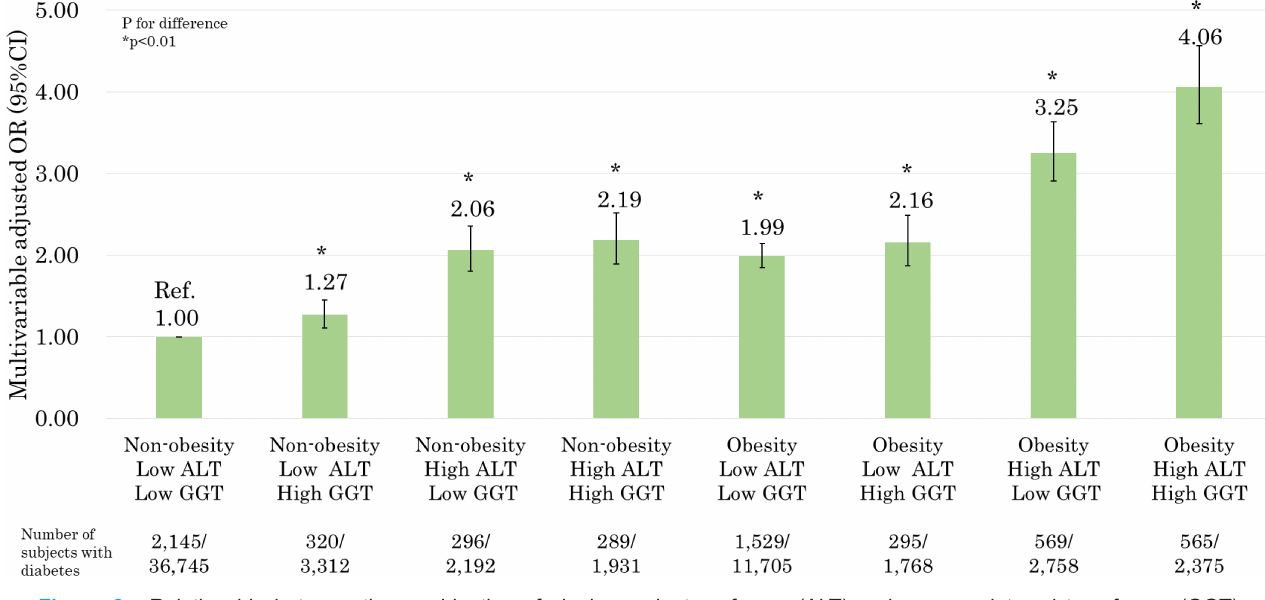
Figure 2. Relationship between the combination of alanine aminotransferase (ALT) and gamma-glutamyl transferase (GGT) levels with the prevalence of diabetes mellitus (DM) in obese and non-obese individuals (adjusted for age, sex, smoking status, alcohol drinking status, family history of diabetes, hypertriglyceridemia, high low-density lipoprotein [LDL], low high-density lipoprotein [HDL], hypertension, physical activity, and area). P values for di ff erence were derived from multiple logistic regression analysis. Bars represent 95% con fi dence